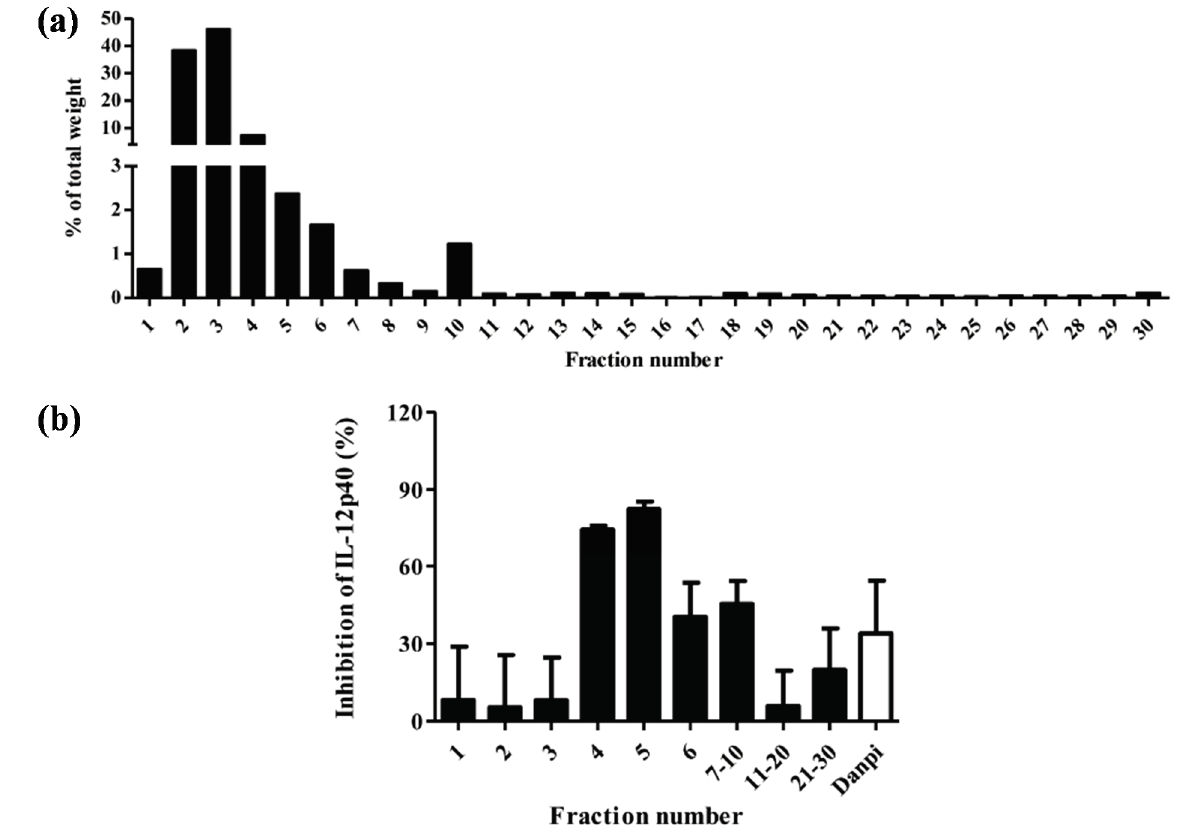
Figure 1. High-Speed Counter-Current Chromatography (HSCCC) of Cortex Moutan. ( a ) The percentage of total weight of 30 HSCCC fractions; ( b ) The effects of the 30 fractions and Cortex Moutan aqueous extract (CM) on IL-12p40 production in monocyte-derived dendritic cells. Values represent mean ± SEM ( n = 3). Fractions (200 µg/mL) were added to DC and cultured for 48